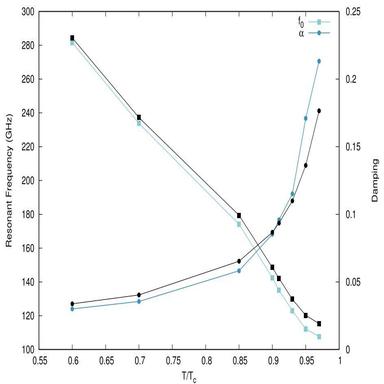
Damping and resonant frequency as a function of temperature for a micromagnetic FePt system parameterised using 5nm × 5nm × 10nm FePt atomistic simulations compared to the expected analytical values (black lines).